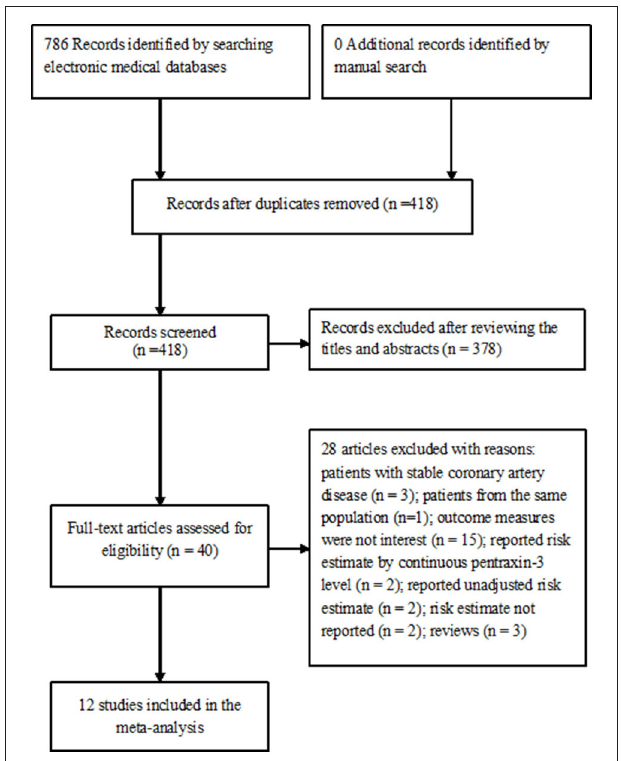
FIGURE 1 | Flow diagram showing study selection